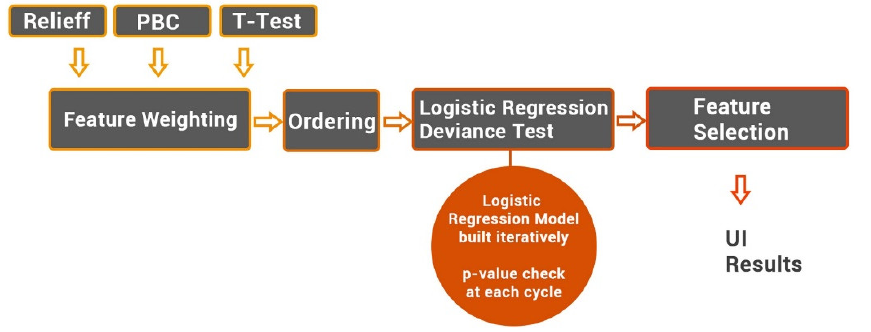
Figure 3. Feature selection workflow.